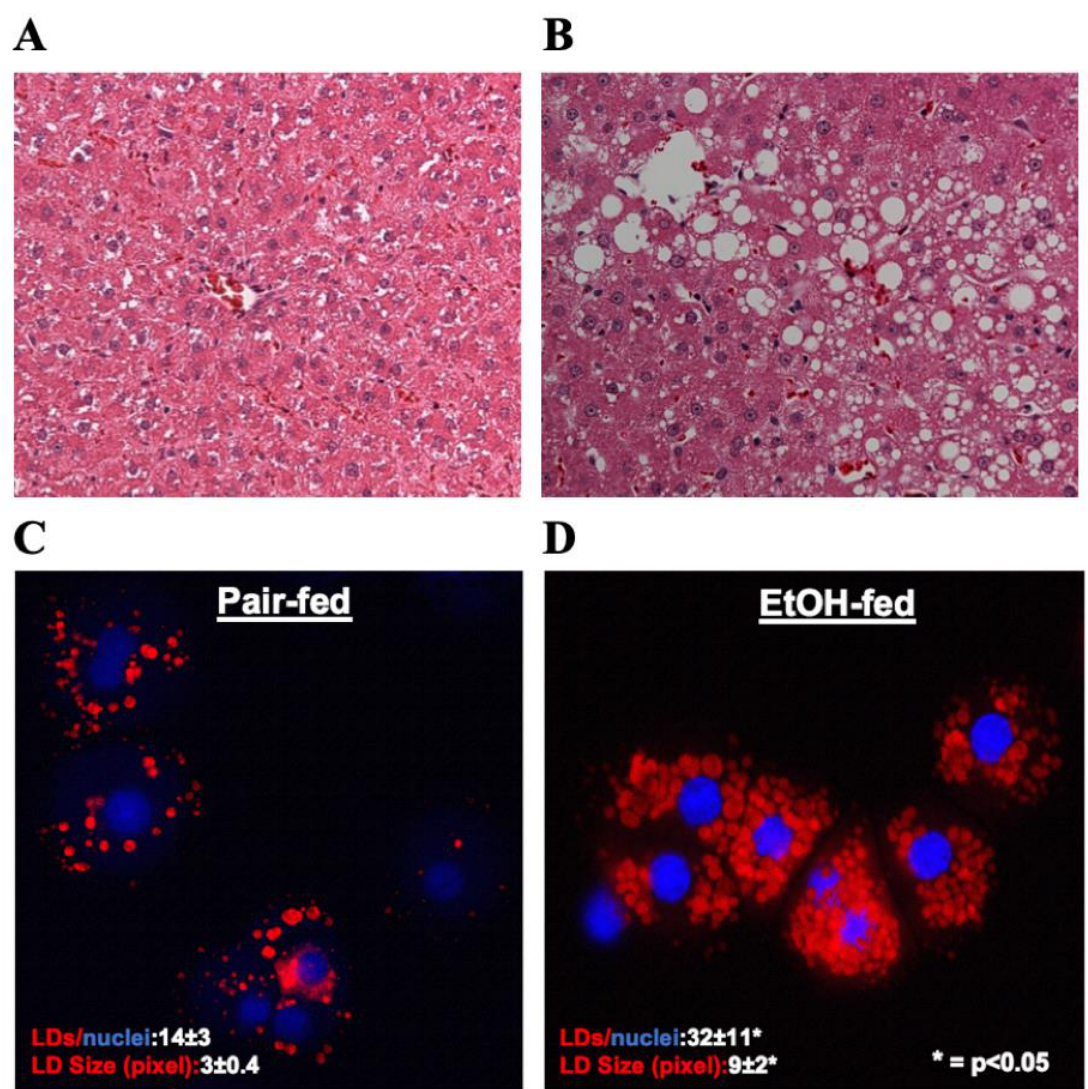
Figure 1. (A & B) Hematoxylin and Eosin staining was performed on paraffin sections of control and EtOH-fed rat livers. Images are representative of each group. Magnification, 200×. (C & D) Oil red O staining of LDs in hepatocytes isolated from control and EtOH-fed rat livers. Images are representative of each group.